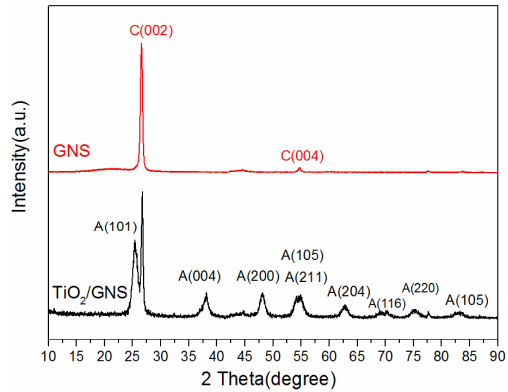
Figure 3. XRD patterns of GNs and TiO 2 /GNs composite.